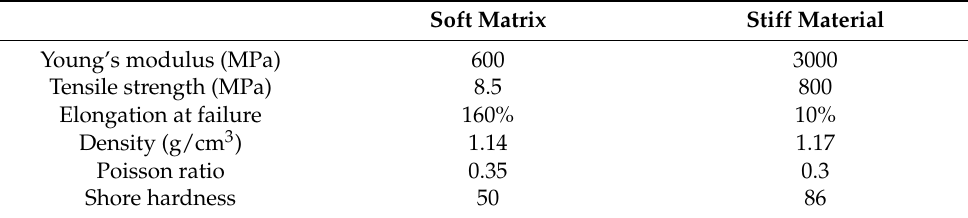
Table 1. Materials parameters.